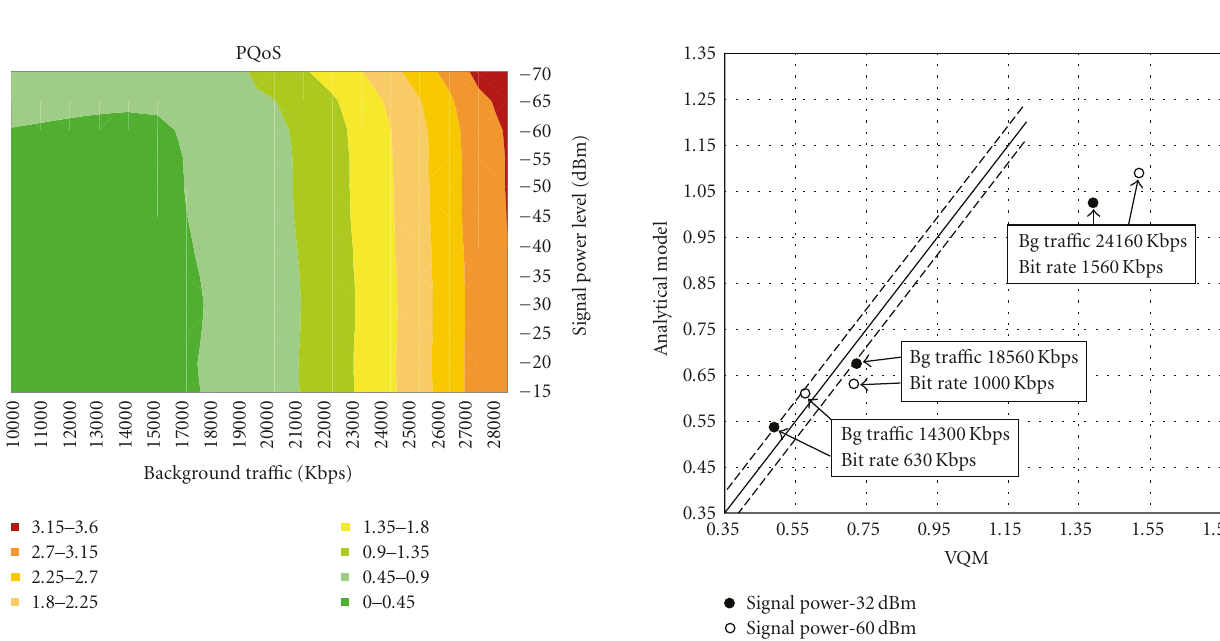
Figure 8: PQoS map obtained from the analytical model for a fixed bit rate of 2350 Kbps, background tra ffi c versus signal power level.